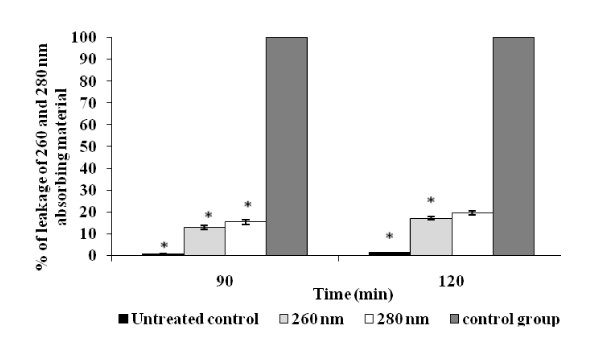
Effect of AKBA on the leakage of 260 and 280 nm absorbing materials in S. aureus ATCC cells. Control group (treated with lytic enzymes and considered as 100% leakage) and treated with AKBA at 64 μg/ml for 90 and 120 min. No compound added served as untreated control. Values are means (±SD) from three independent determinations. *, P < 0.05 (Student's t test), AKBA treated group compared to untreated control group.